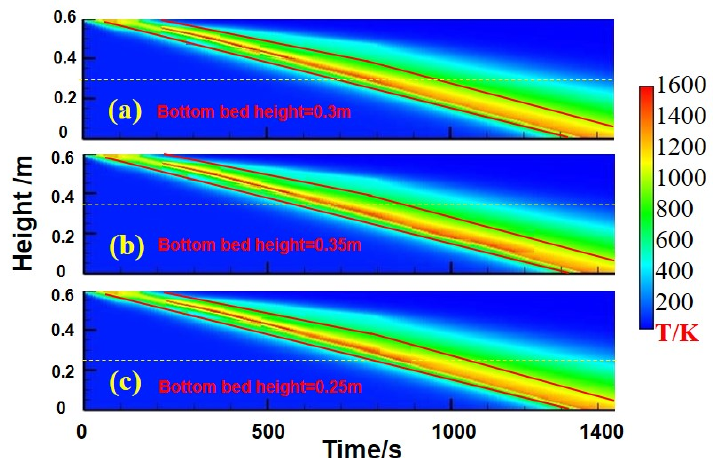
Figure 15. Temperature fields for FSDS technology with different bottom bed heights. ( a ) case I; ( b ) case II; ( c ) case III.